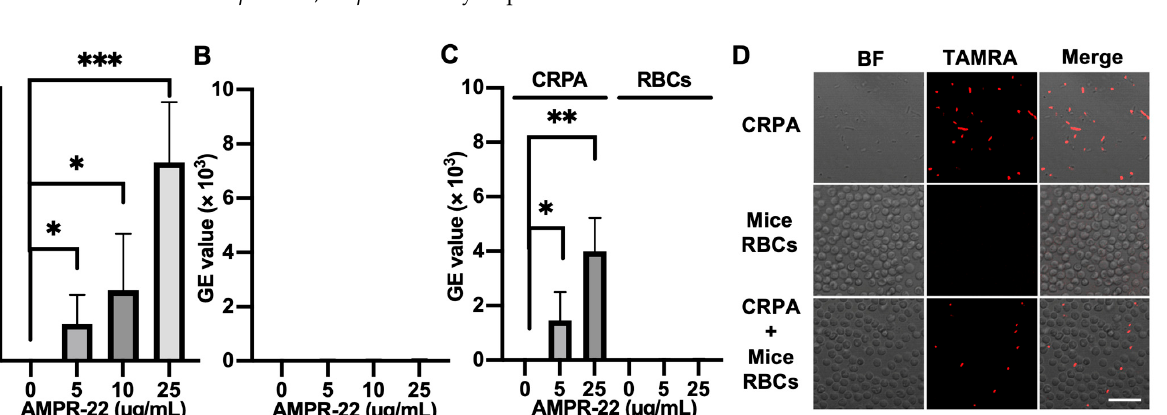
Figure 5. AMPR-22-induced membrane permeabilization. CF-encapsulated OM-LUVs ( A ), IM-LUVs ( B ), or PM-LUVs ( C ) were constructed using the lipid composition used for MD. The LUVs were incubated with 0.1% HFIP (negative control), 1% Triton X-100 (positive control), 2 µM AMPR-22, or 0.05 µM Melittin. ( D ) The membrane permeabilization of OM-LUVs (left panel) or IM-LUVs (right panel) was divided by that of PM-LUVs, representing the membrane preference of AMPR-22. Membrane permeabilization of OM-LUVs with additional lipid A ( E ) or IM-LUVs with additional cardiolipin ( F ). Bars represent average ± standard deviation of three independent experiments. ** p < 0.01, *** p < 0.001 by unpaired t tests.